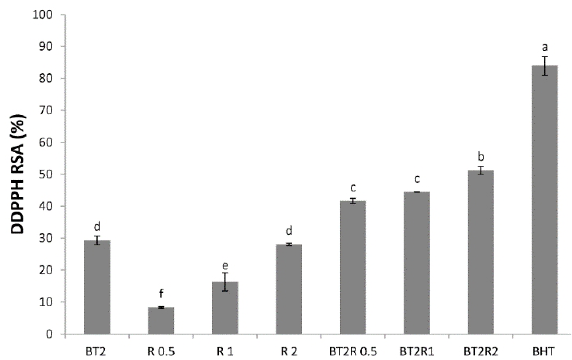
Fig. 2. DPPH Radical Scavenging Activity of Black Tea, Rosa damascena, and their infusions (Small letters show significant differences [P<0.05] among the DPPH scavenging activity of the samples; BHT (2 mg/ml) as the positive